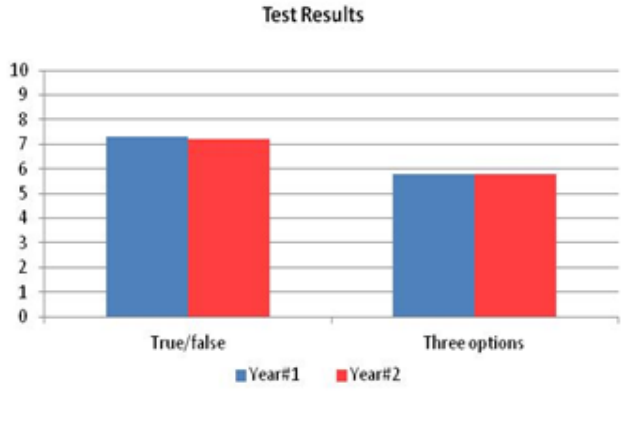
Figure 5. Averaged tests